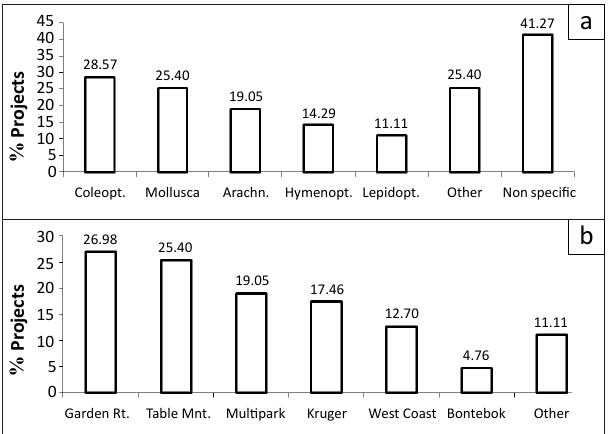
FIGURE 1: Percentage of research projects ( n = 63) on invertebrates (a) per taxon and (b) per park (including nontaxon specific projects) currently registered with South African National Parks (as at November